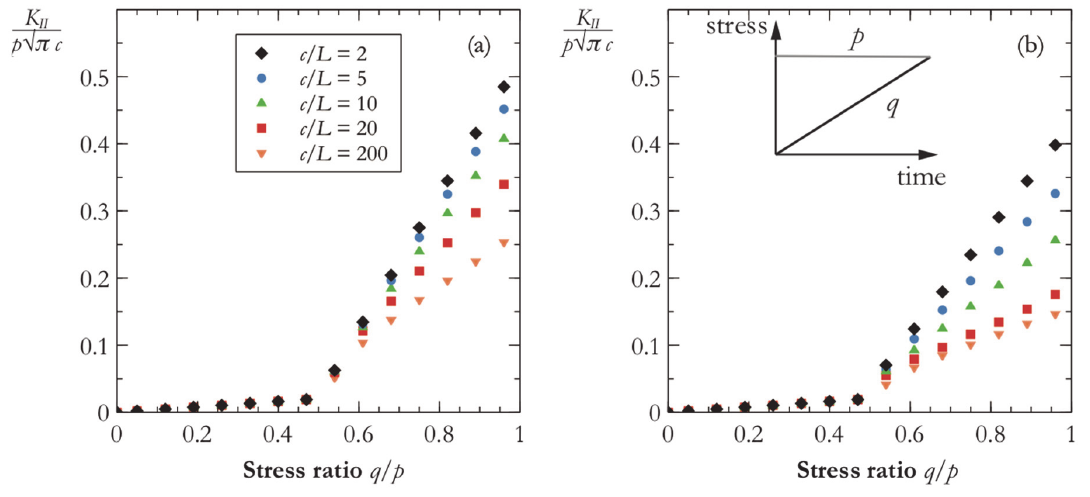
Figure 2: The normalised stress intensity factor K II versus the applied load ratio q/p . Different relative crack lengths c/L are considered. f =0.5. (a) Angle of the surface asperity  =2° and (b) angle of the surface asperity  =5°. The inset shows the loading